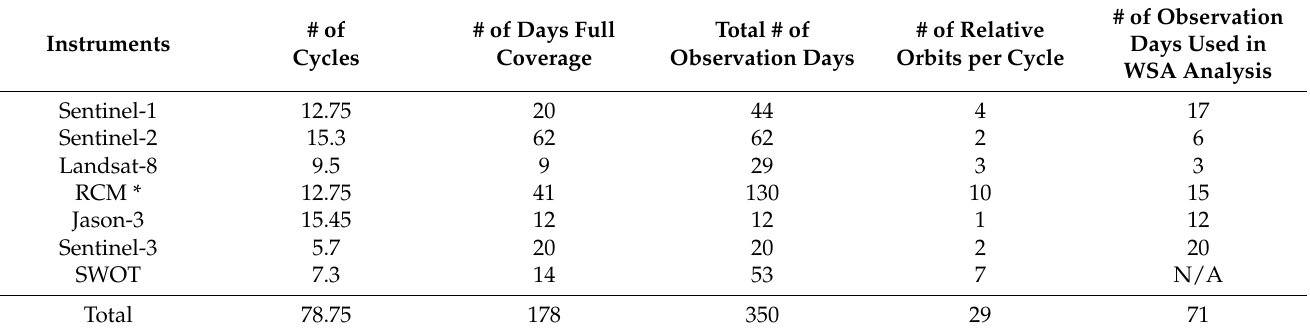
Table 2. Summary of remote sensing data